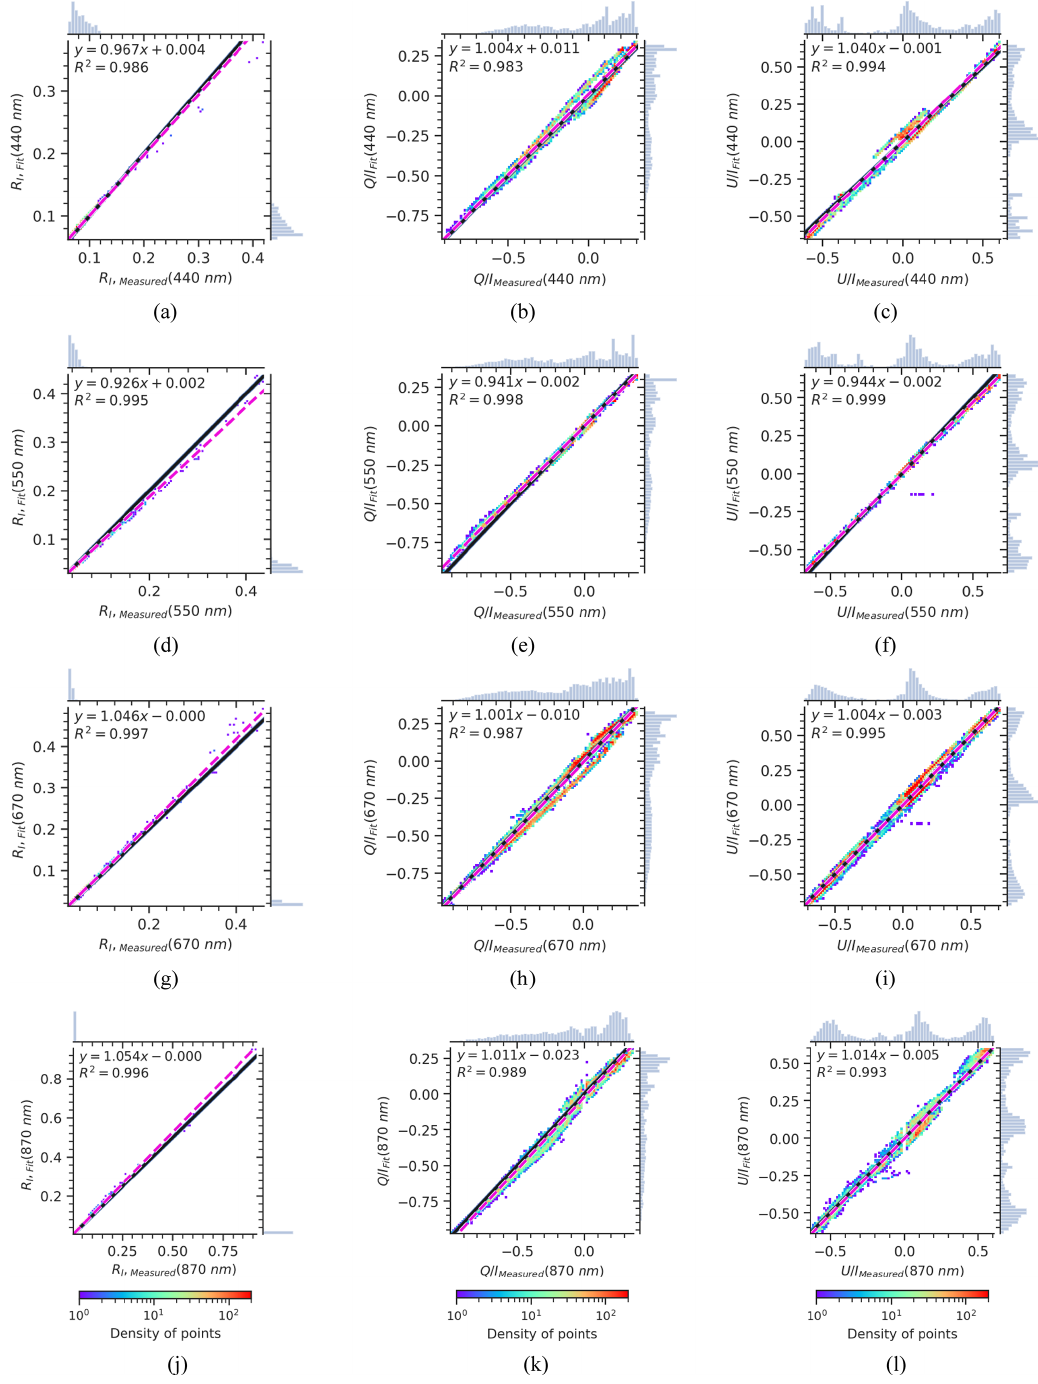
Figure 6. Scatter density plots for AirHARP measurement variables and GRASP fit for the ocean scene in Fig. 4a. The subplots (a, d, g, j) are the 2-D density plots for variable R I at different spectral bands blue, green, red and NIR, respectively; (b, e, h, k) are for the variable Q/I ; (c, f, i, l) are for the variable U/I . The dashed magenta line is the ordinary least square (OLS) fit for the measured and GRASP-fitted variable. The solid black line is the 1 : 1 line for the measured and fitted variable. There are 72000 data points for the 440, 550, and 870nm bands and 216000 data points for the 670nm band. For each plot, the histogram of measurement and GRASP fit for each variable are plotted on the top and right axes,